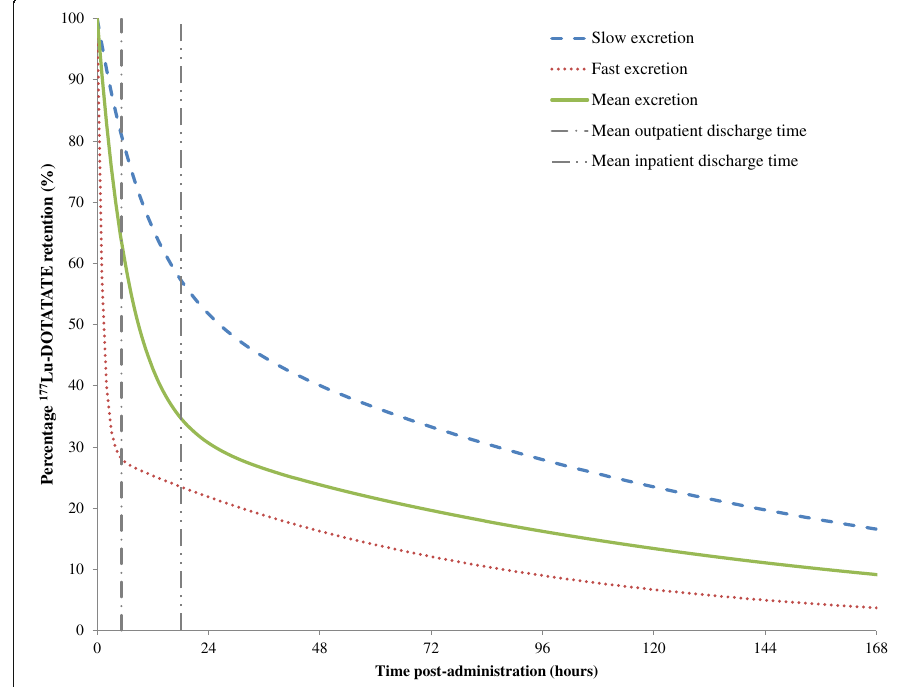
Fig. 1 Examples of fitted 177 Lu-DOTATATE retention curves up to 168 h post-administration for patients with slow ( A s = 0.44, A l = 0.56, T s = 7.4, T l = 95.6) and fast excretion ( A s = 0.76, A l = 0.24, T s = 3.9, T l = 67.1). The mean curve fit and times of outpatient and inpatient discharge are also shown